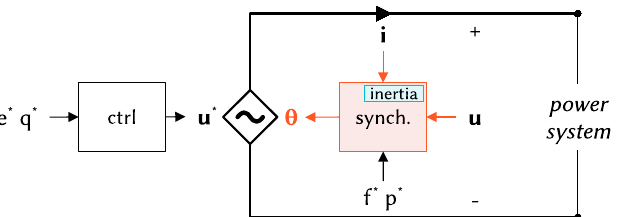
Figure 2. Fundamental representation of grid-forming synchronisation mechanism and controls with inertia